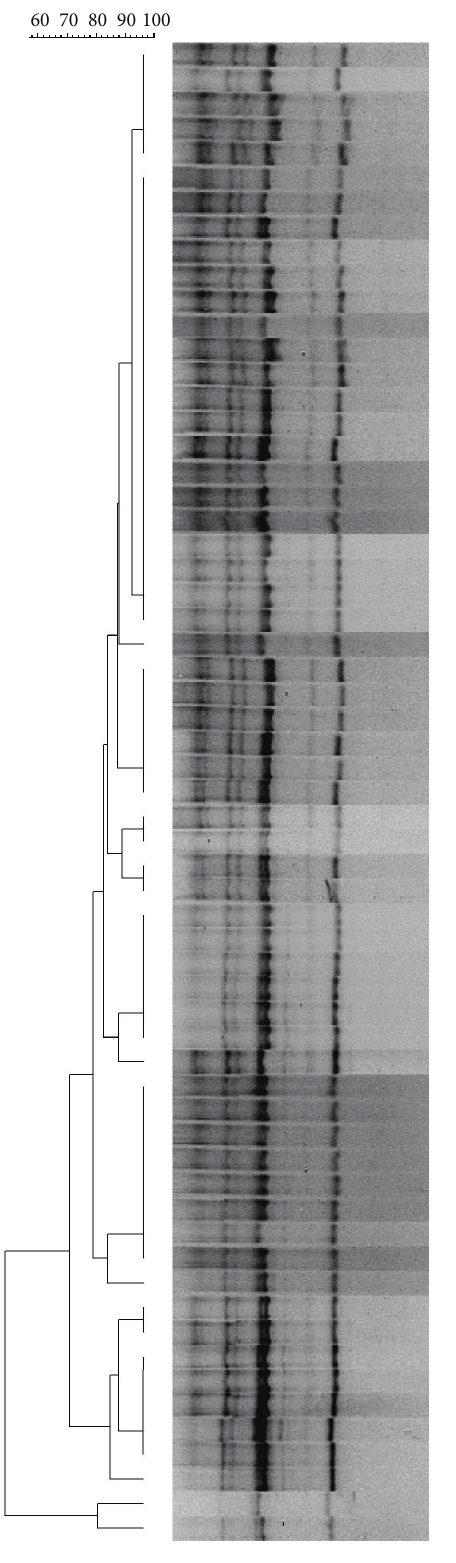
Figure 1: Dendrogram showing comparison of Y. enterocolitica biotype 4/O:3 isolates by